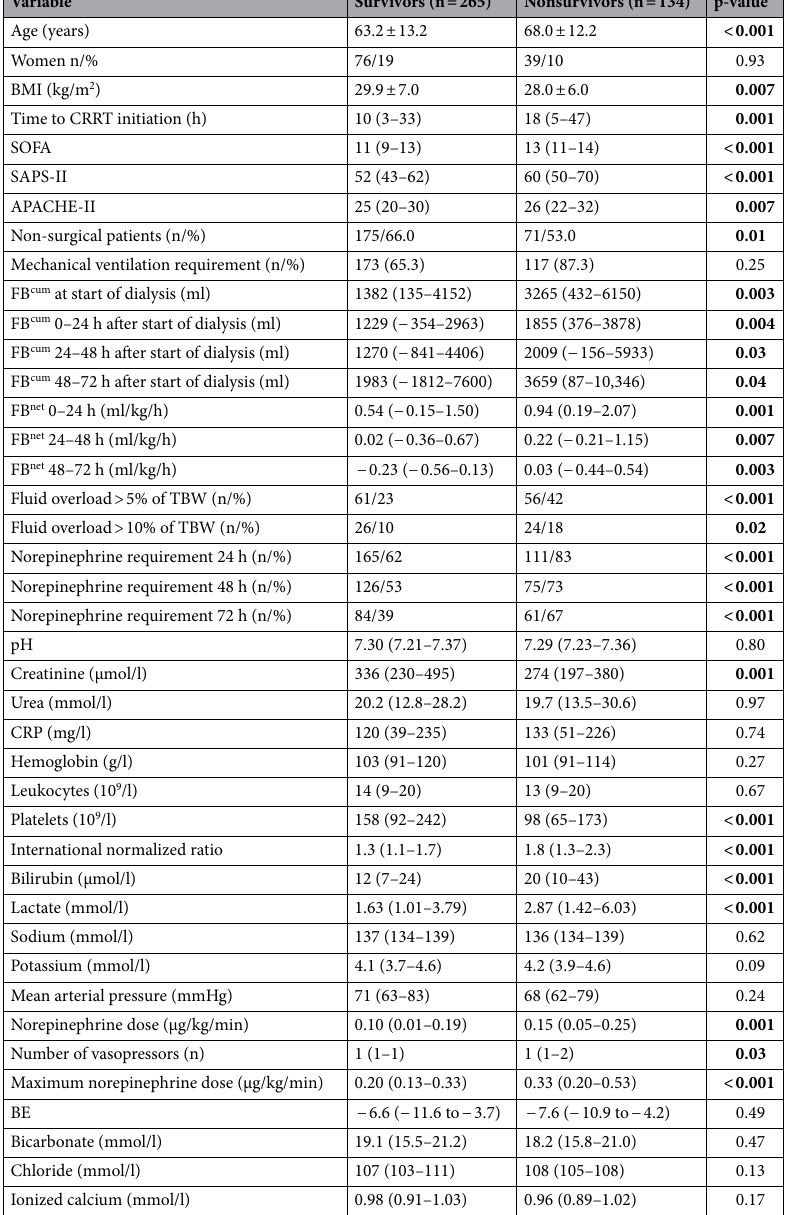
Table 2. Characteristics of hospital survivors compared to non-survivors. Values are mean ± SD or median (IQR). Values are given at CRRT initiation, unless stated otherwise. BMI Body Mass Index, CRRT Continuous Renal Replacement Therapy, SOFA Sequential Organ Failure Assessment Score, SAPS-II Simplified Acute Physiology Score, APACHE-II Acute Physiology And Chronic Health Evaluation Score II, FB cum Cumulative Fluid Balance, FB net Mean Hourly Fluid Balance Per Bodyweight; CRP C-reactive Protein, BE Base